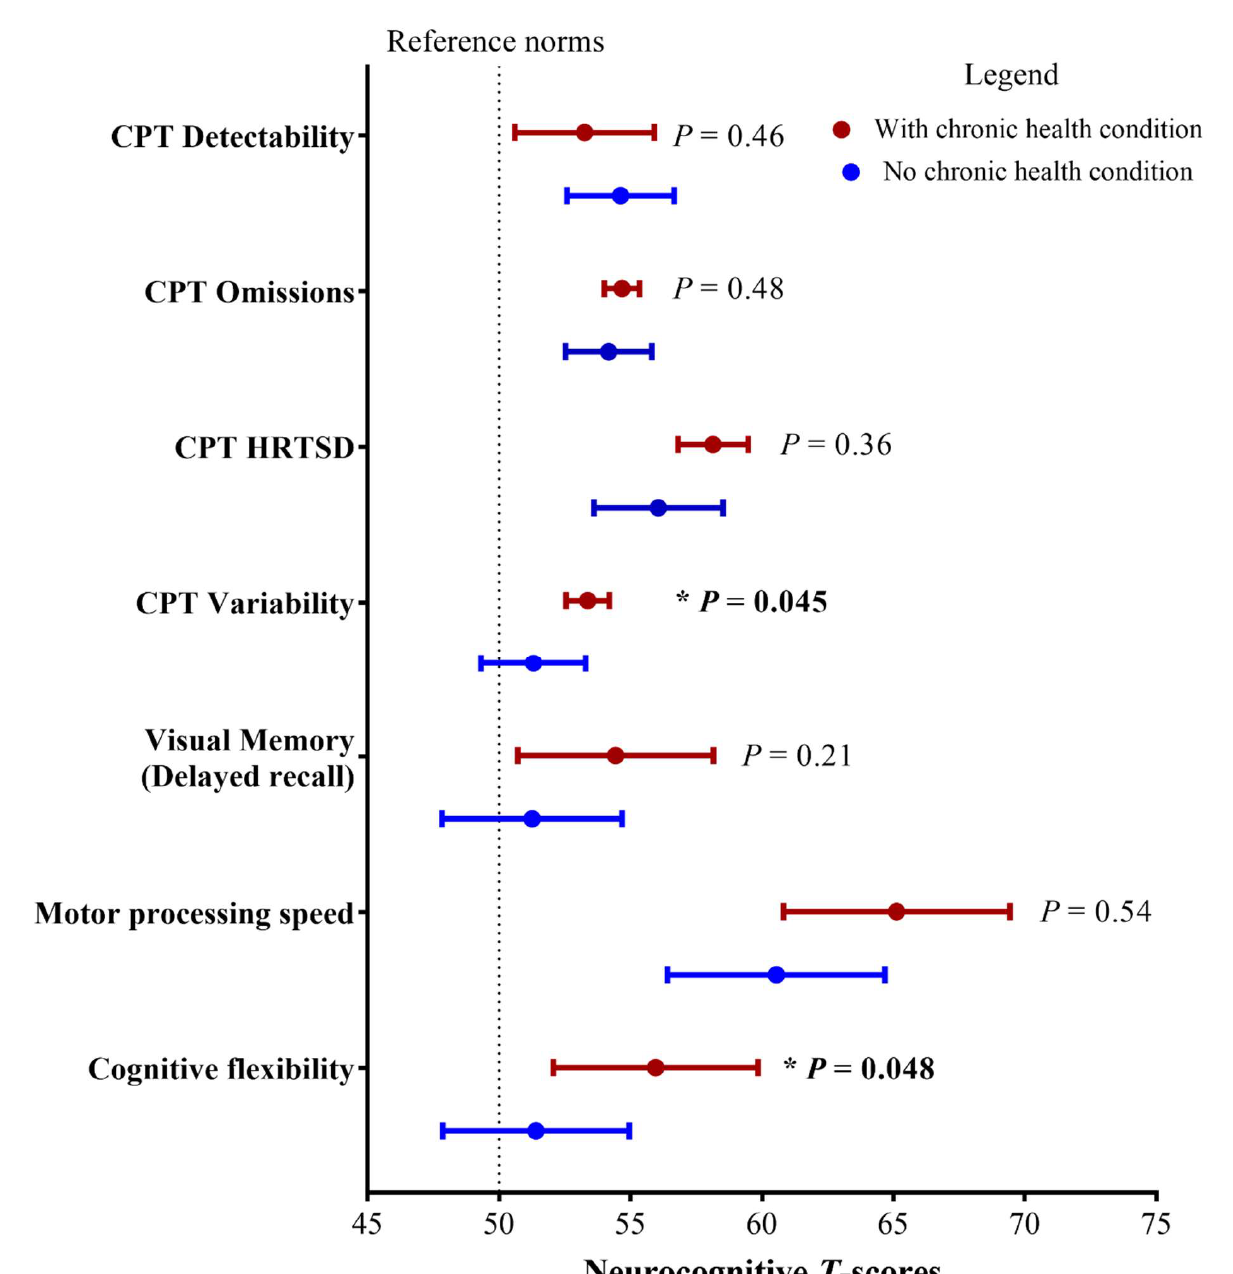
Figure 1. Association between chronic conditions and neurocognitive outcomes. CPT: Conners Performance Test-III for attention; HRTSD: hit reaction time standard deviation. There were 43 survivors who had developed cardiac, pulmonary, endocrine and metabolic or renal condition(s). These survivors’ neurocognitive scores were compared with survivors who did not develop chronic conditions using general linear modelling, adjusting for age at diagnosis, sex and highest educational attainment. A higher T score is indicative of worse functioning. * p < 0.05.